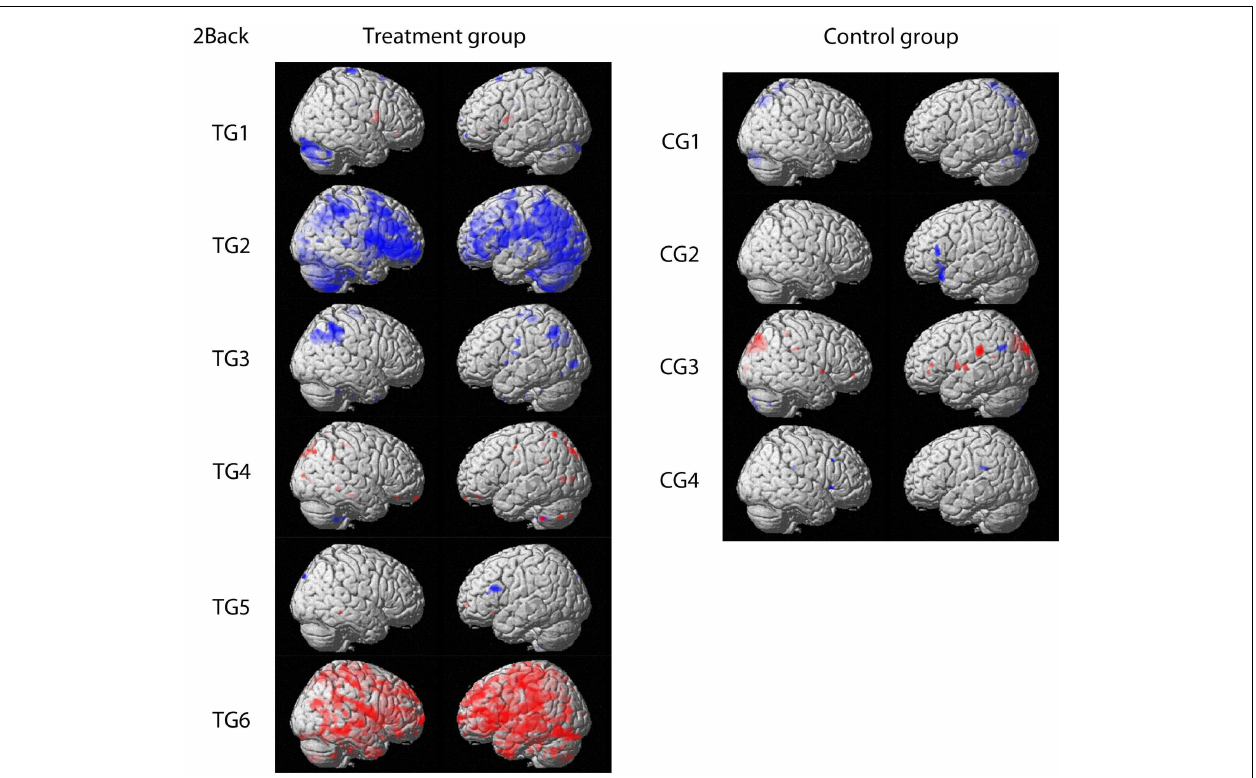
FIGURE 1 | Contrasts comparing baseline and post-training fMRI results for the treatment group and the control group, respectively . Activation increase is marked in red whereas decreased activation over time is highlighted in blue ( p < 0.001 uncorrected; threshold: 10 voxels per cluster). Figures are shown in radiological